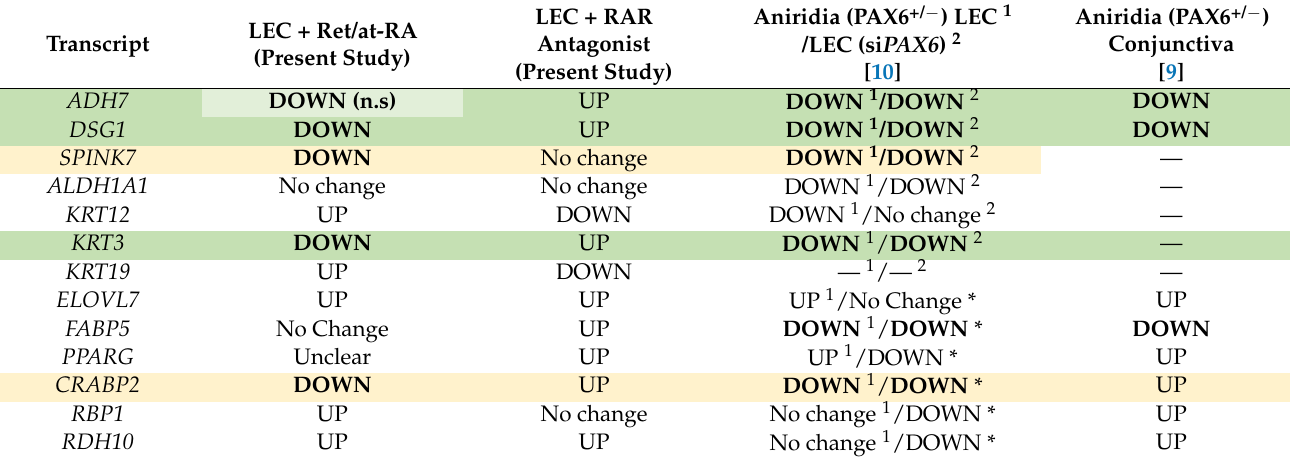
Table 1. mRNA expression changes in limbal epithelial cells (LEC) following treatment and in aniridia patient cells. Transcripts with similar behaviour through retinol (Ret)/all trans-retinoic acid (at-RA) stimulation and in aniridia-related models or primary limbal epithelial cells (LEC) are highlighted in green. Transcripts with unexpected response in one of the cellular systems are highlighted in yellow. Transcripts not reacting according our hypothesis are not highlighted. RAR: retinoic acid receptor; siPAX6: siRNA based cell model with PAX6 knockdown; 1 = primary LECs from aniridia